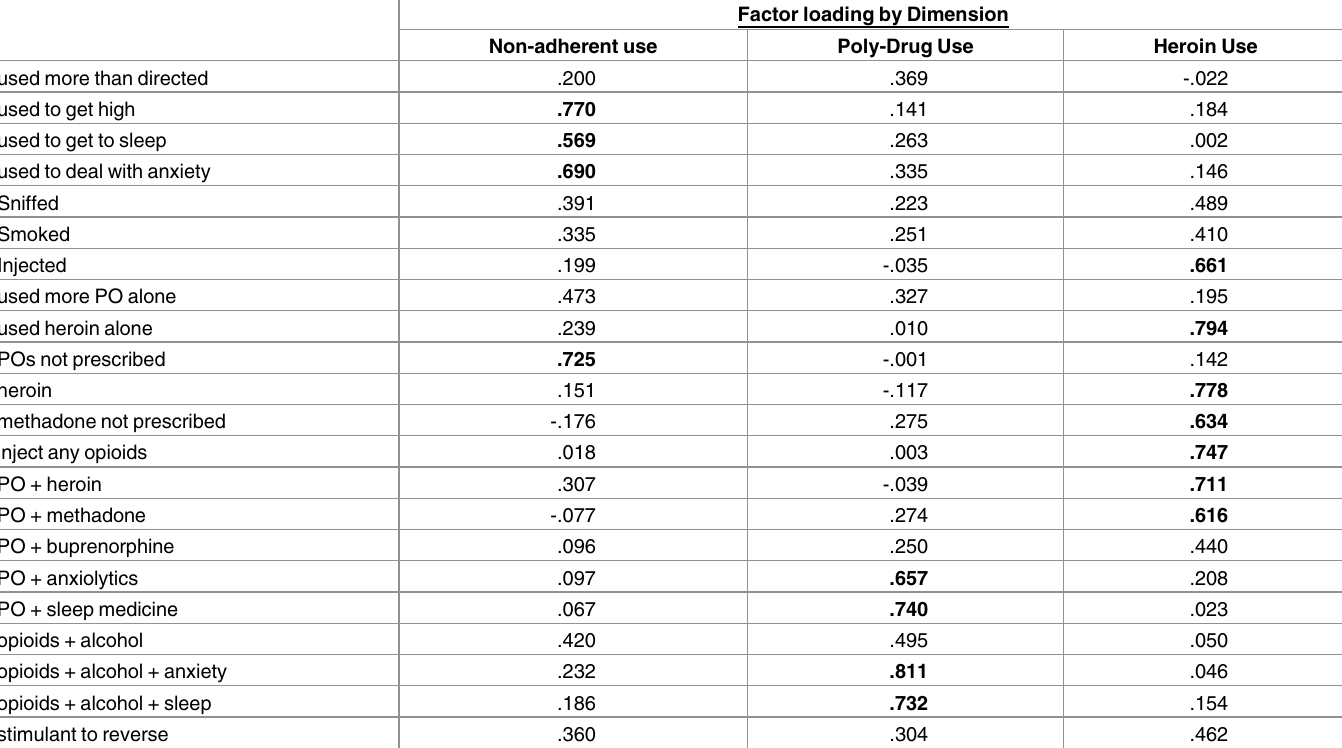
Table 4. Three dimensions of opioid risk behaviors among veterans(Factor